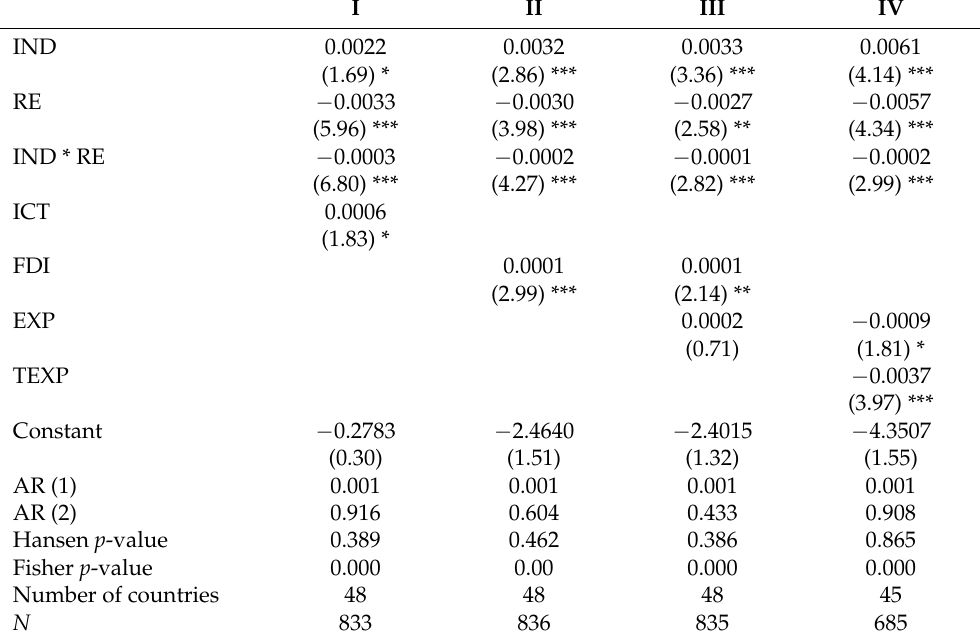
Table 4. Robustness